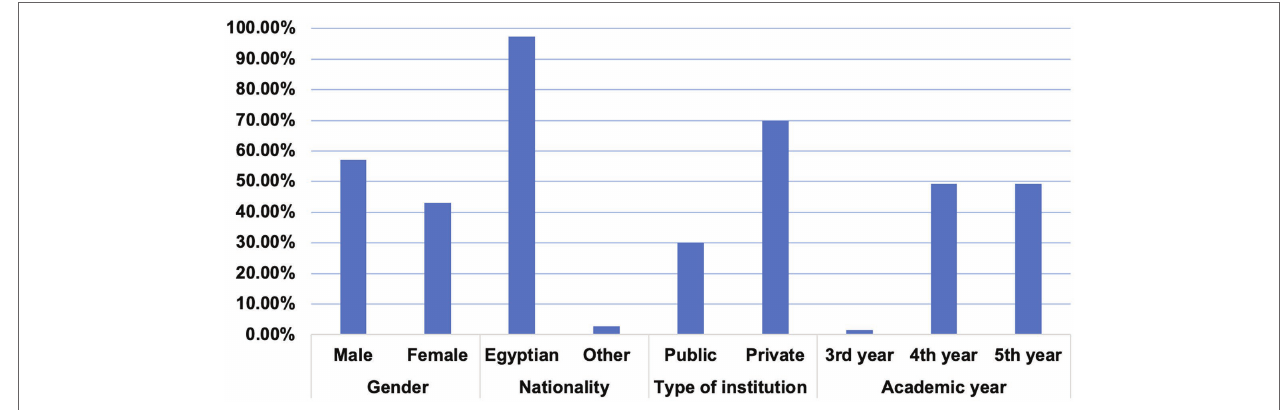
FIGURE 1 | Bar chart showing percentage values for demographic